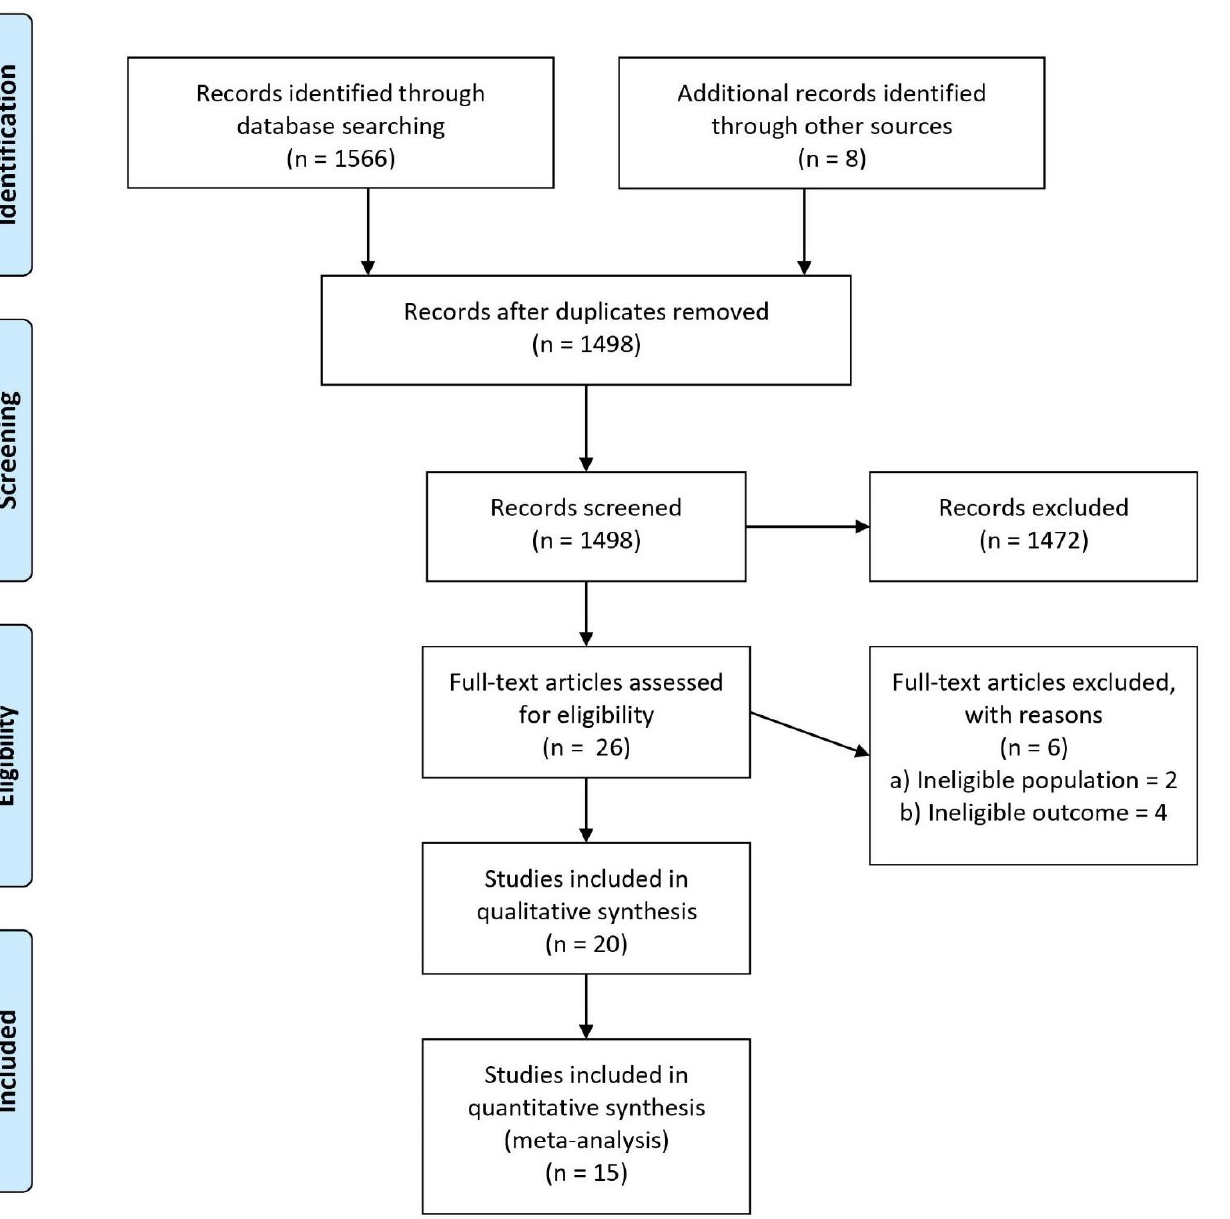
Figure 1. PRISMA flow diagram for selection of studies.